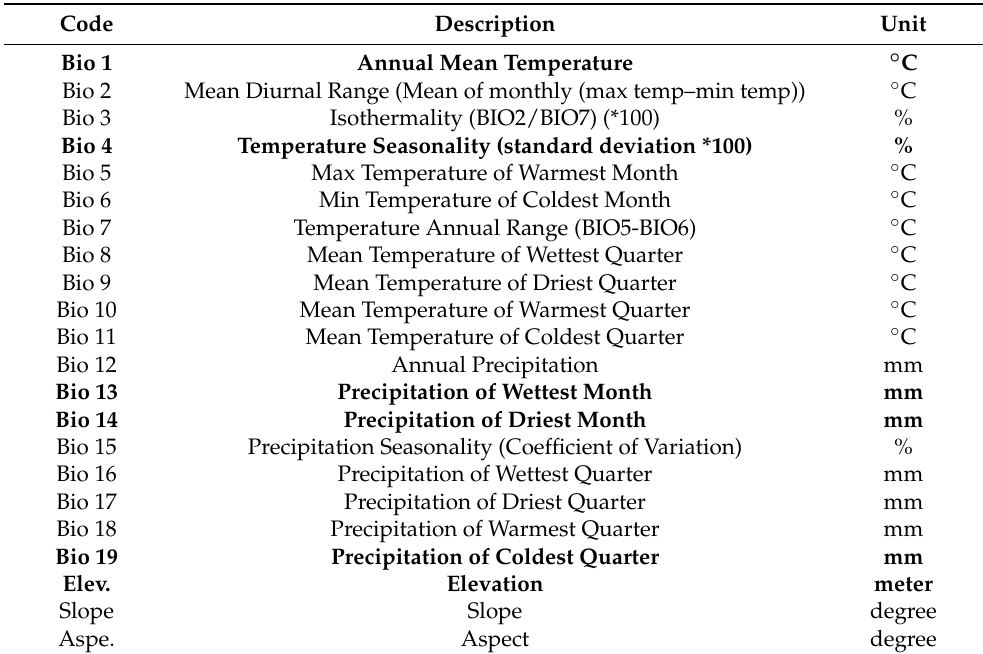
Table 1. Description of variables used in the prediction of the MaxEnt model. The variables in bold were selected through Pearson’s correlation analysis and were used in the modelling.